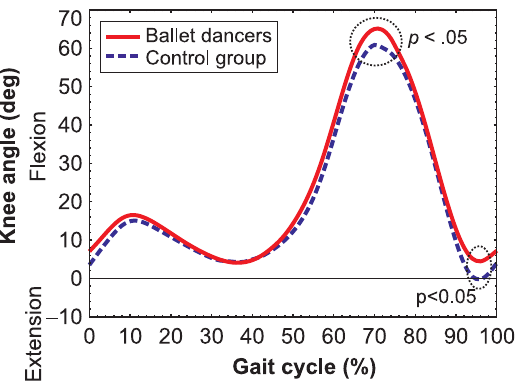
Figure 4 . Hip movement in the frontal plane during gait in dancers and the control group